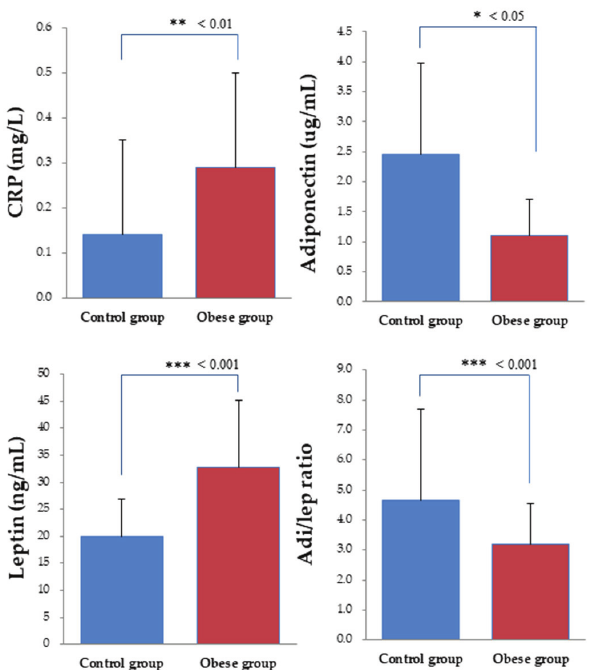
Figure 3. Biochemical values of the normal-weight control group and the obese group.